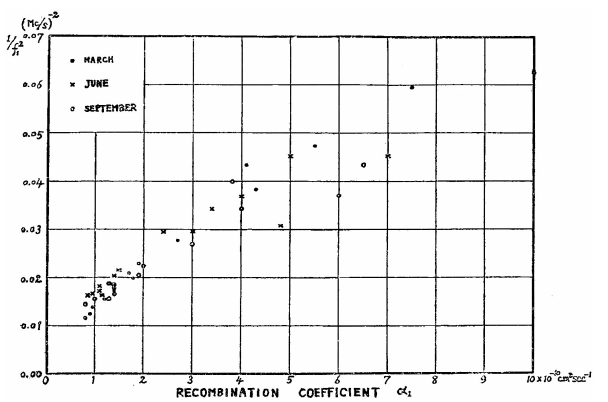
Figure 7. Horizontal axis is the coe ffi cient that is obtained by fitting the recombination model and vertical axis is the inverse of ( fo F2) 2 . There should not be a linear relation if the recombination model were applicable (Yonezawa,